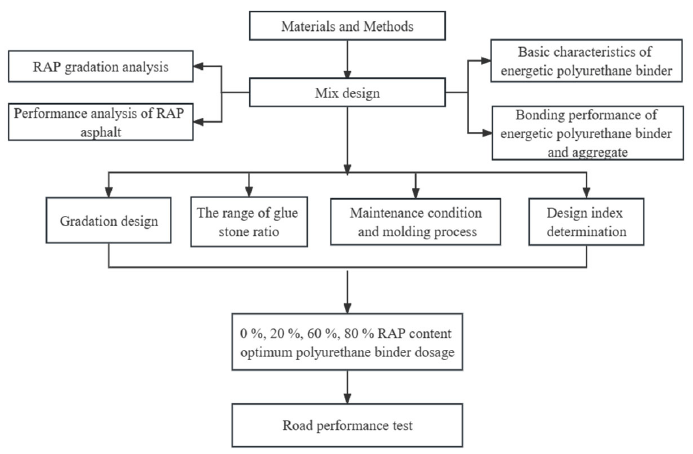
Figure 1. Flowchart of materials and methods.